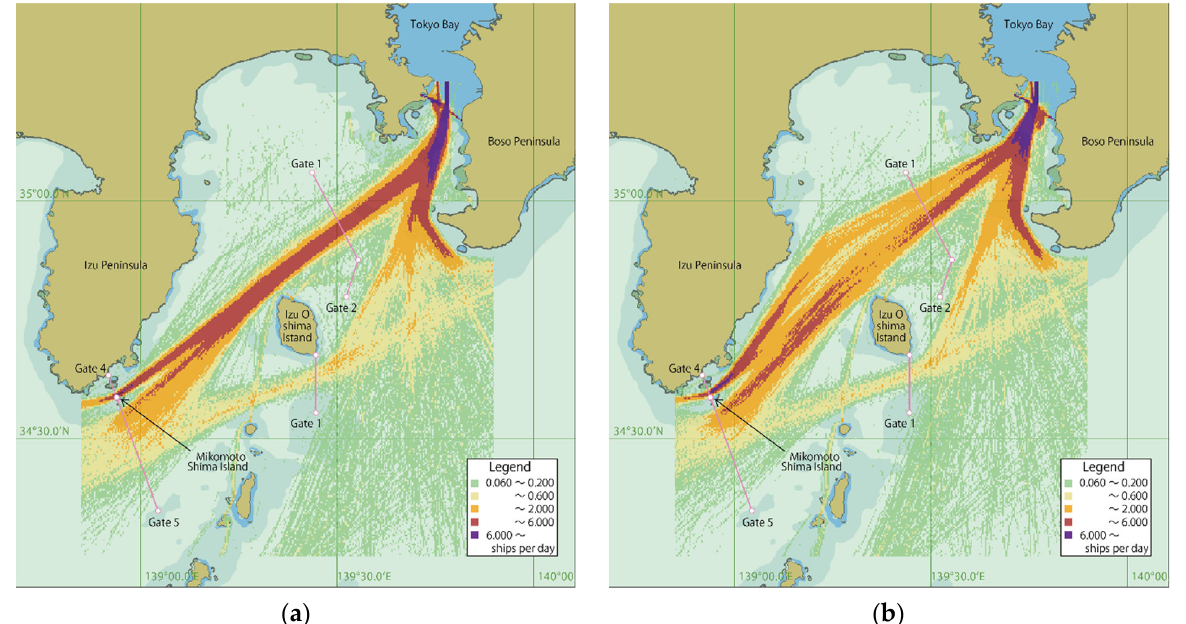
Figure 6. Traffic density distribution of navigating ships in the waters west of Izu O Shima Island. (Analyzed using the AIS data in March 2014). ( a ) Eastbound ships. ( b ) Westbound ships. Note: the description of Gates 1 to 5 is in Section 4.2.1 (Source: AIS data from 1 March to 31 March 2014, provided by Toyo-shingo-tsushinsha (TST) [32]).